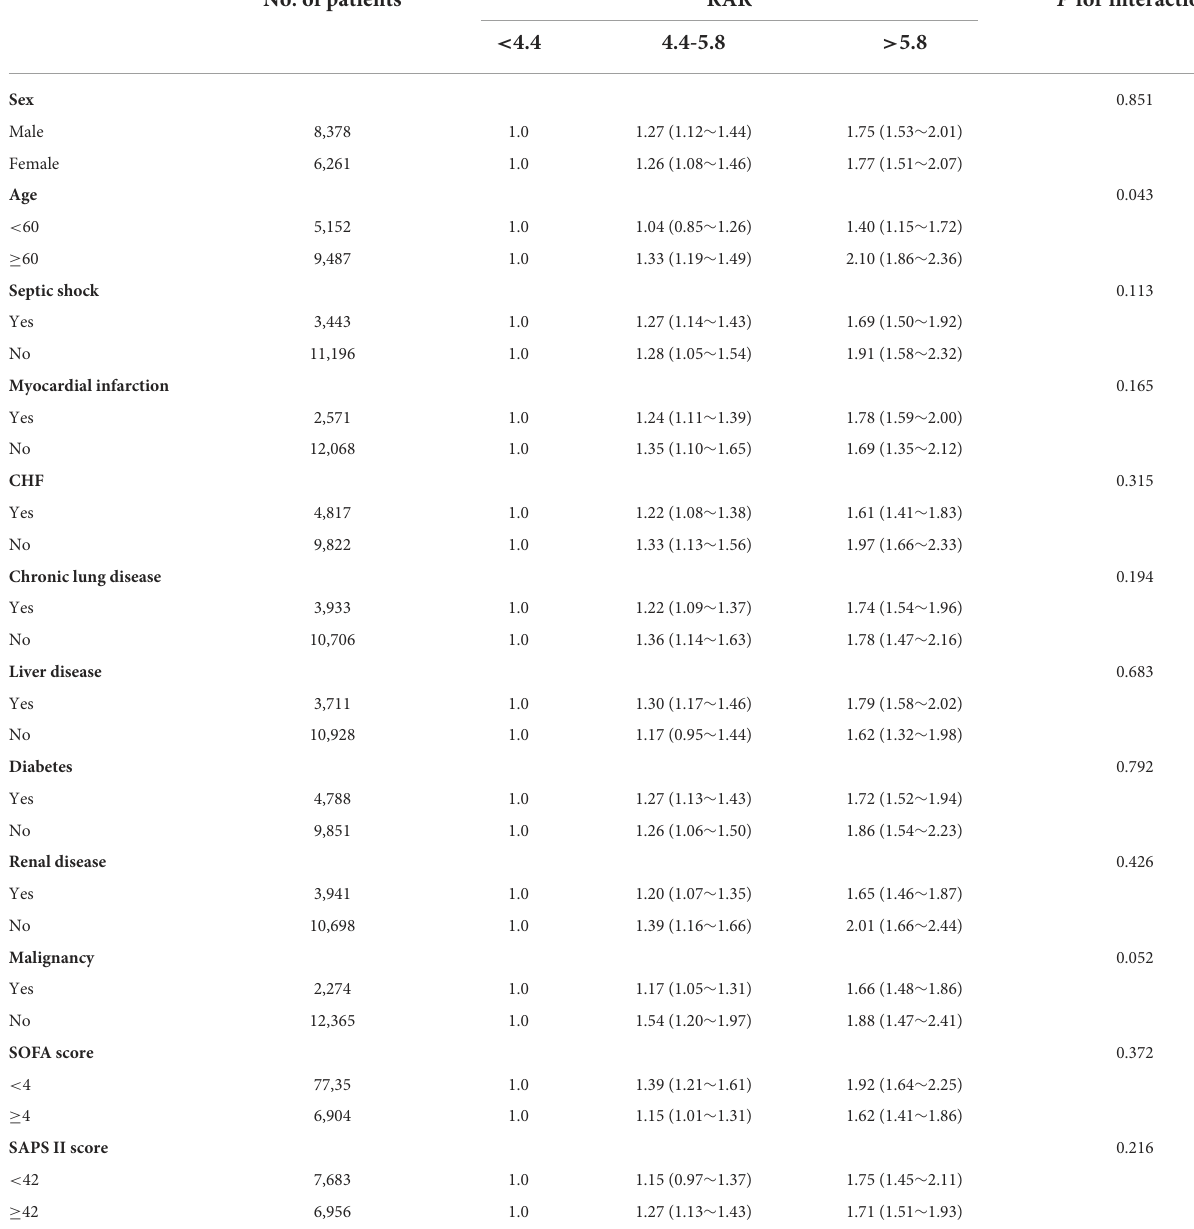
TABLE 3 Subgroup analysis of the associations between 28-day mortality and the RAR level. No. of